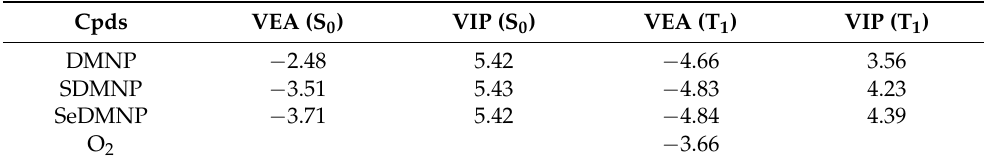
Table 1. B3LYP-D3/6-31+G(d,p) Vertical electron affinity (VEA) and vertical ionization potential (VIP) of DMNP, SDMNP, SeDMNP, and O 2 in DMSO, in